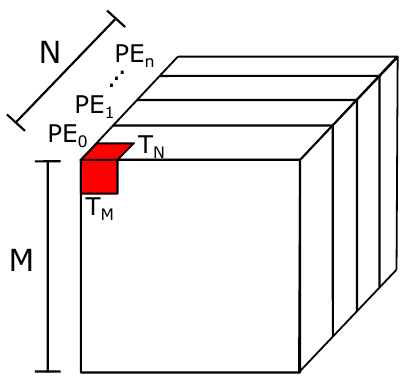
Figure 10. Partition of feature maps for parallel PE processing.